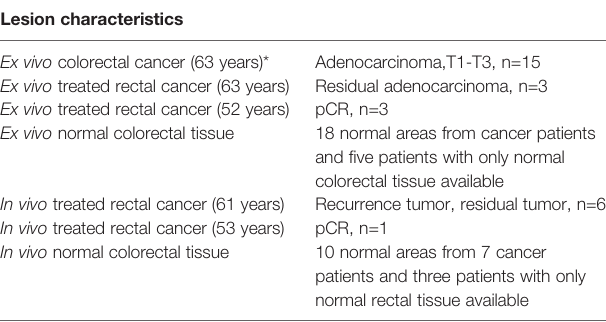
TABLE 1 | Lesion characteristics (24 ex vivo colorectal specimens and 10